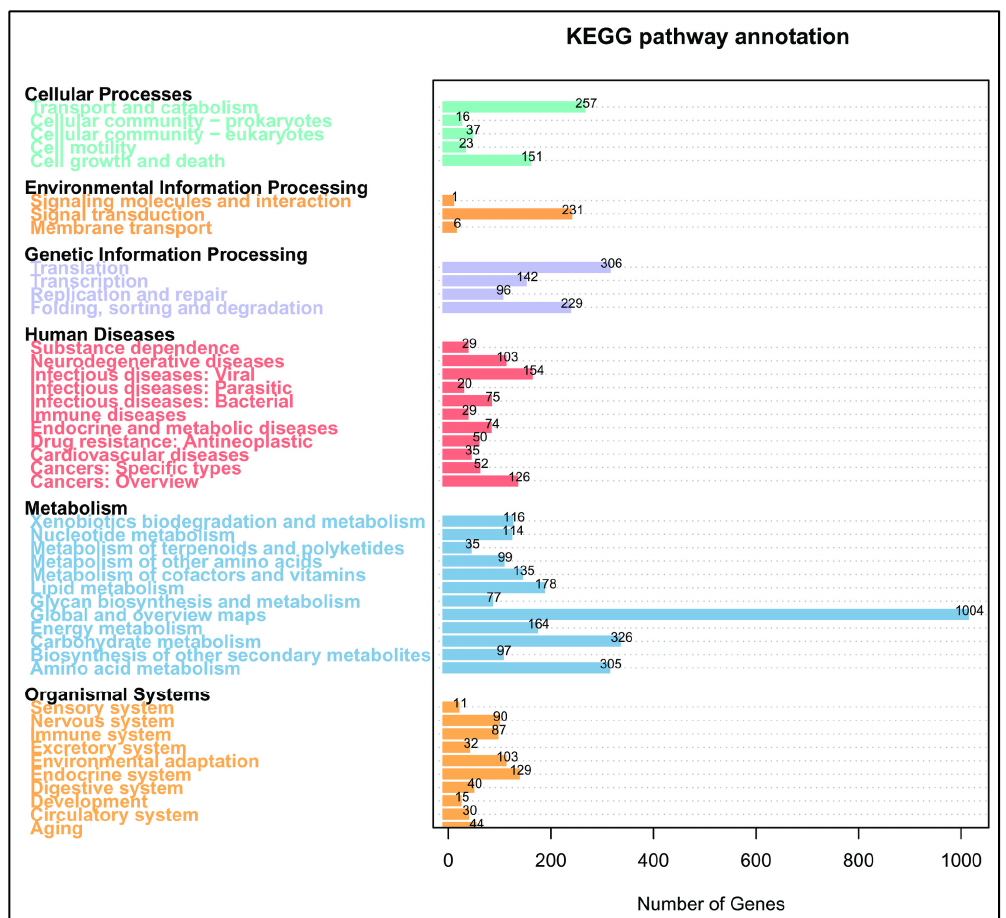
Figure 2. Represents the (KEGG) functional annotation of the A. rasikravindrae genome. In this figure, the major classes with their names and the number of genes from the concerned sub-class divisions are represented. The X-axis represents the scale for several genes up to 1000. KEGG functional annotation is divided into six major classes viz; Cellular process, Environmental information processing, Genetic information processing, Human diseases, Metabolism or Organismal system, and 40 subclasses. Each sub-class has been represented with a distinct color.